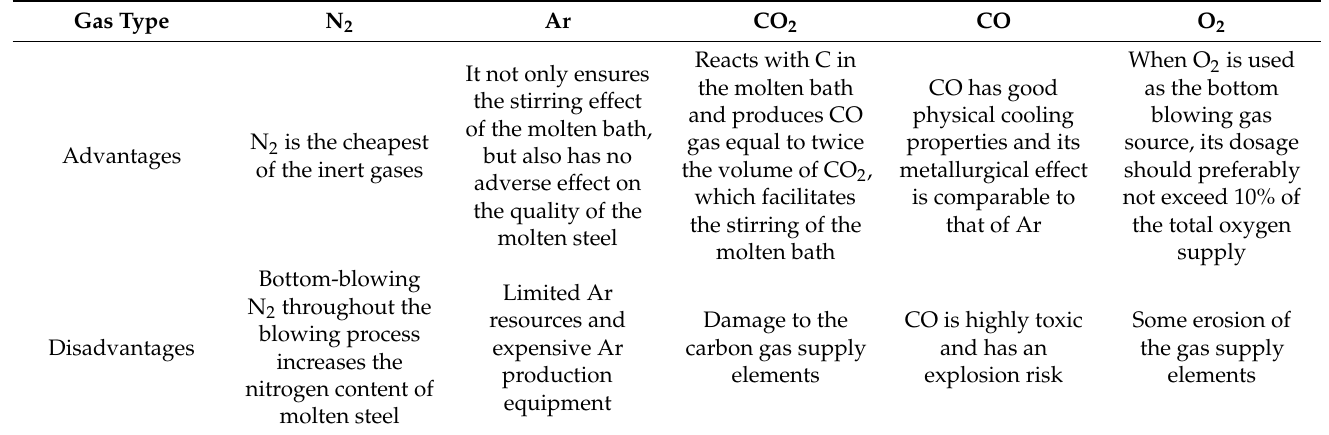
Table 6. Different bottom blowing gas characteristics.